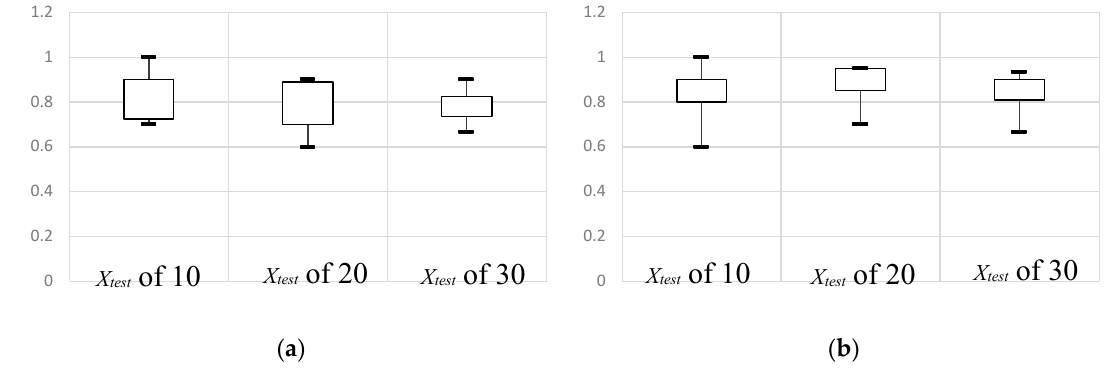
Figure 5. Boxplots of the proposed method with c = 5. ( a ) LSSVMFS; ( b ) SVMFS